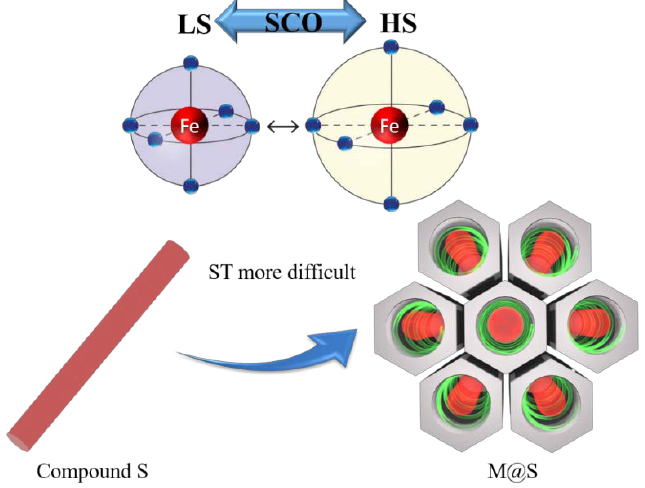
ff ect” from the walls of